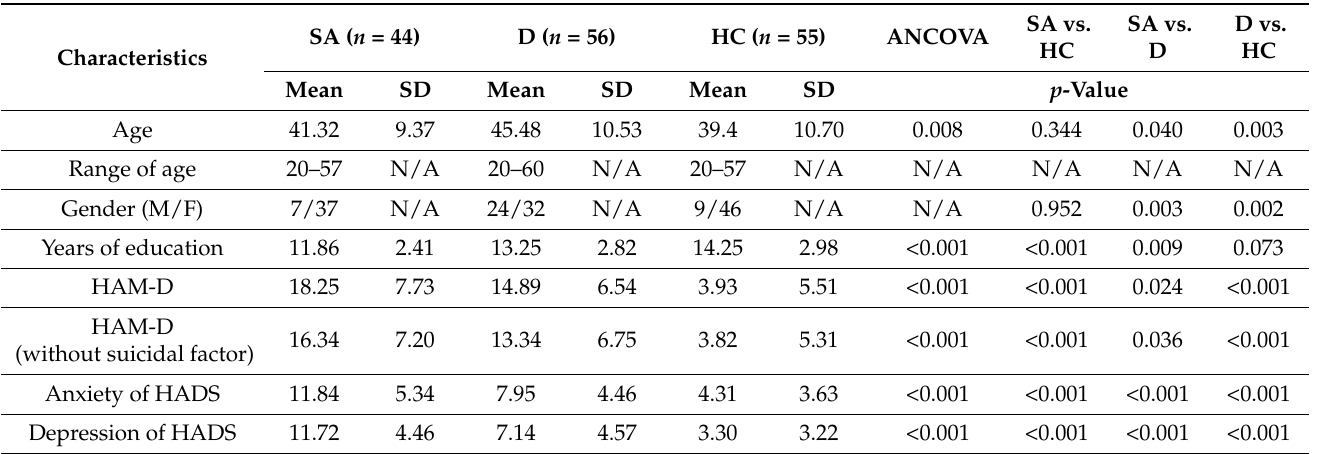
Table 1. Demographic characteristics.